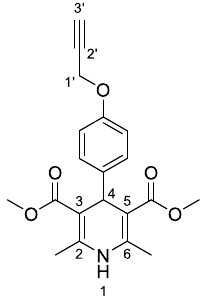
Figure 2. Chemical stucture of 3a .